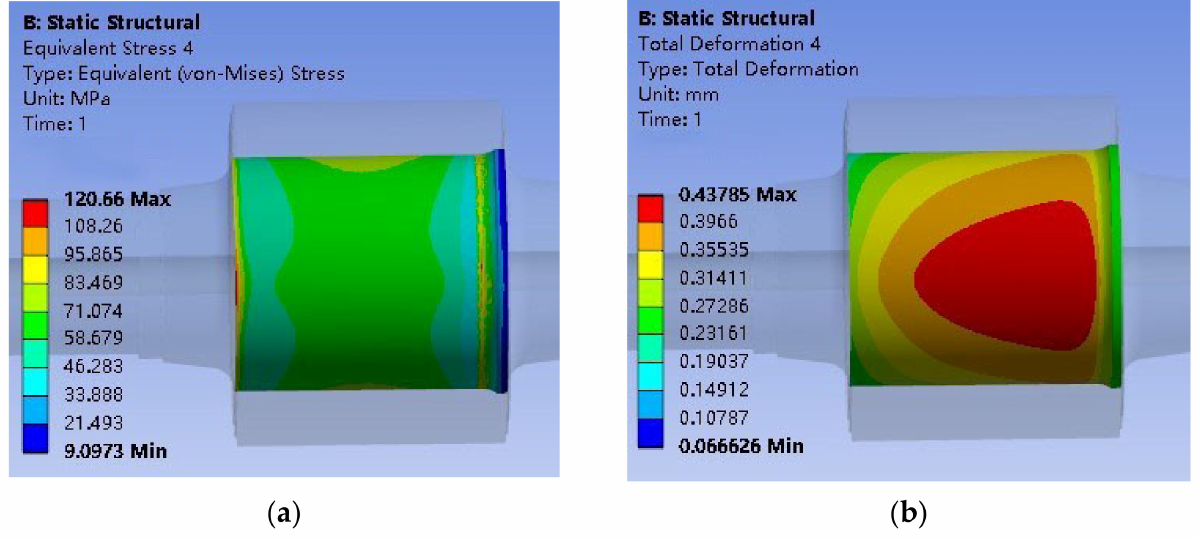
Figure 20. Simulation nephograms of optimized roller shaft: ( a ) equivalent stress nephogram; ( b ) deformation